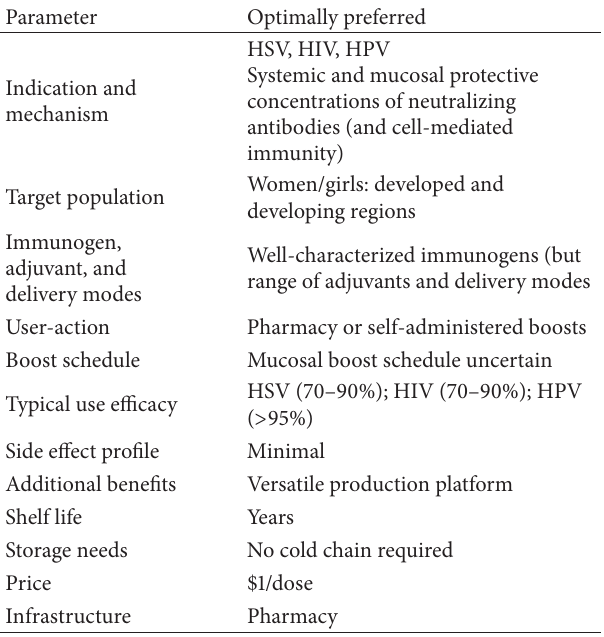
Table 4: Reproductive Health Consensus Target Product Profile for MPT